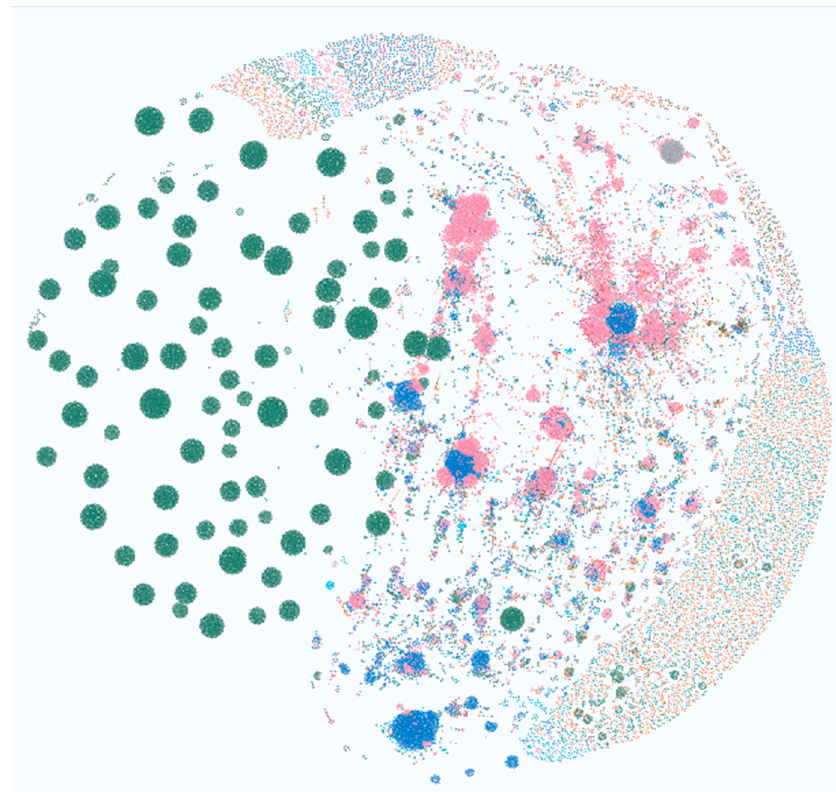
Figure 9. Graphical visualization of the GeoDBpedia21 dataset.